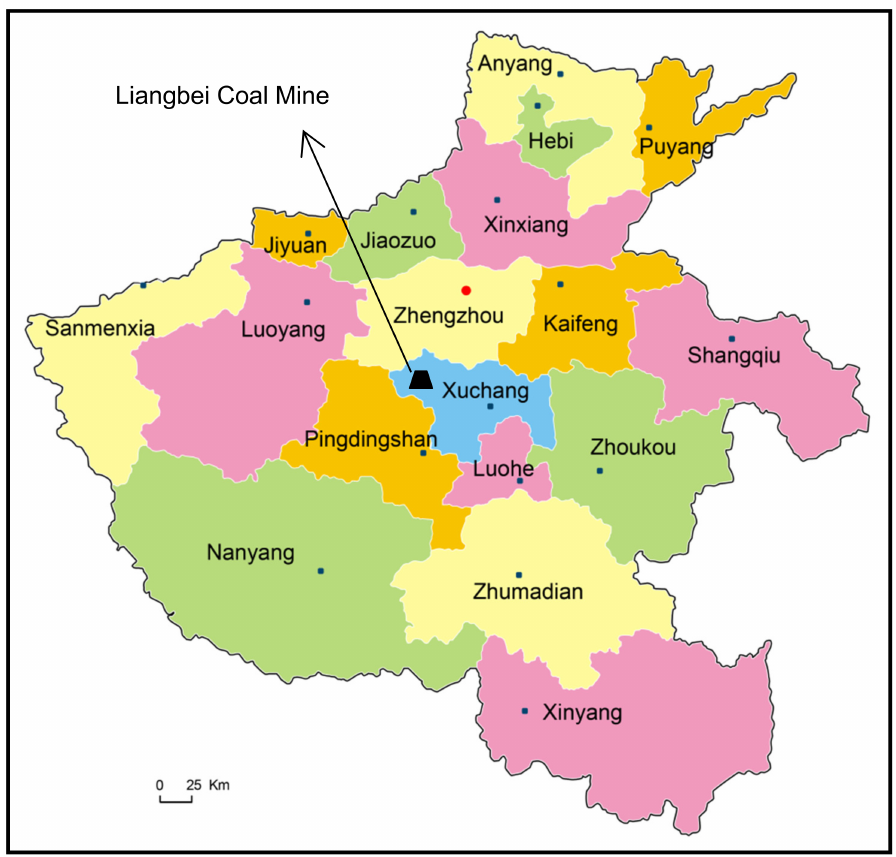
Figure 1. Geographical location of Liangbei Coal